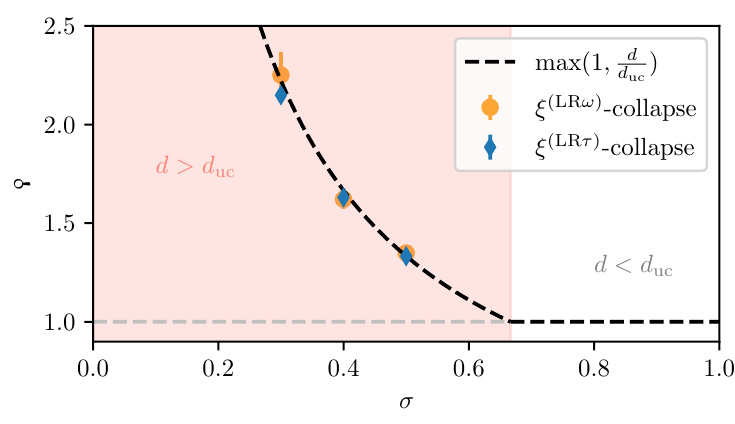
Figure 4: Pseudo-critical exponent ϙ as a function of the decay parameter σ . ϙ was extracted by data collapses of the finite-size characteristic length scale ξ ( LR τ ) (see Eq. (58)). Both agree within error with the predictions of Eq. (56)) and ξ L in the mean-field regime σ < 2 and clearly outrule the long-standing belief ϙ = d 3 d uc that ξ ∼ L . The data of the characteristic length scale used to extract ϙ and the numerical values of ϙ are provided in Ref. [ 71 ]